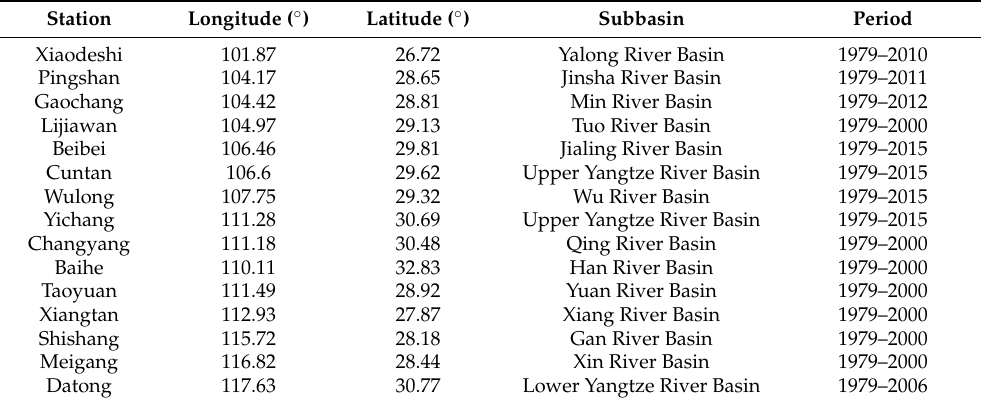
Table 1. Main hydrological stations of the mainstream and tributaries of the Yangtze River